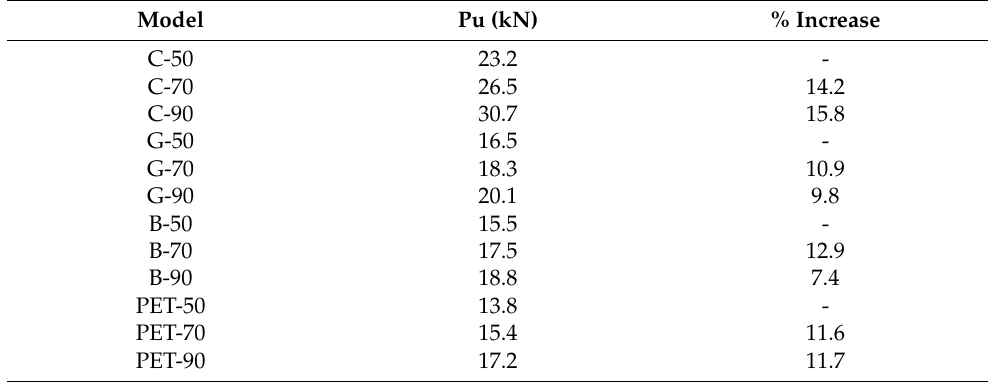
Table 4. Numerical predicted